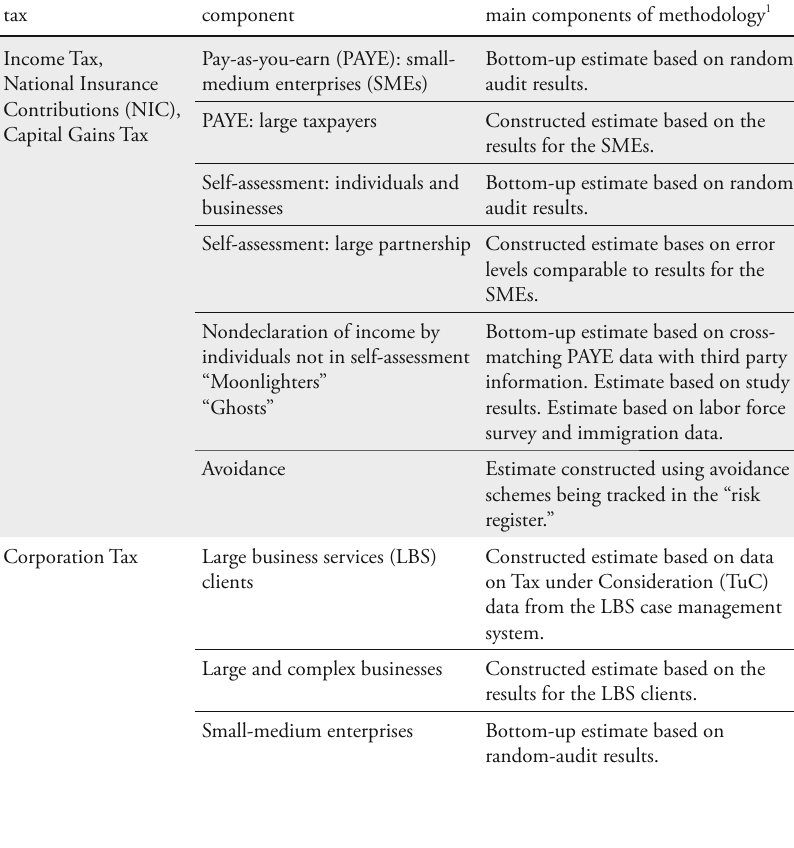
Table 10: Summary of Tax Gap Estimate Methodologies in the United Kingdom tax main components of methodology